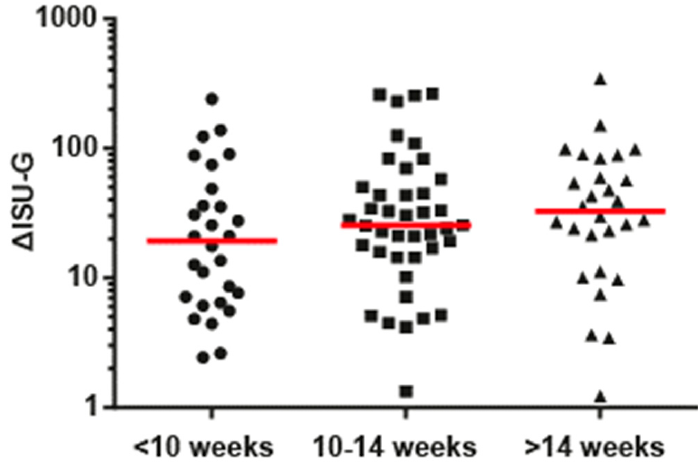
Figure 2. Increases of RV-specific IgG responses in children according to the time points of the follow-up visits. Shown are increases of IgG responses to VP1-derived peptides of RV-A, -B, and -C ( y -axis: ∆ ISU-G) measured in serum samples collected at the day of a wheezing attack and afterwards. Children were grouped according to the time points of the follow-up visits ( x –axis: <10 weeks, between 10–14 weeks, and >14 weeks). Horizontal lines represent median values of increases of RV-specific IgG levels.